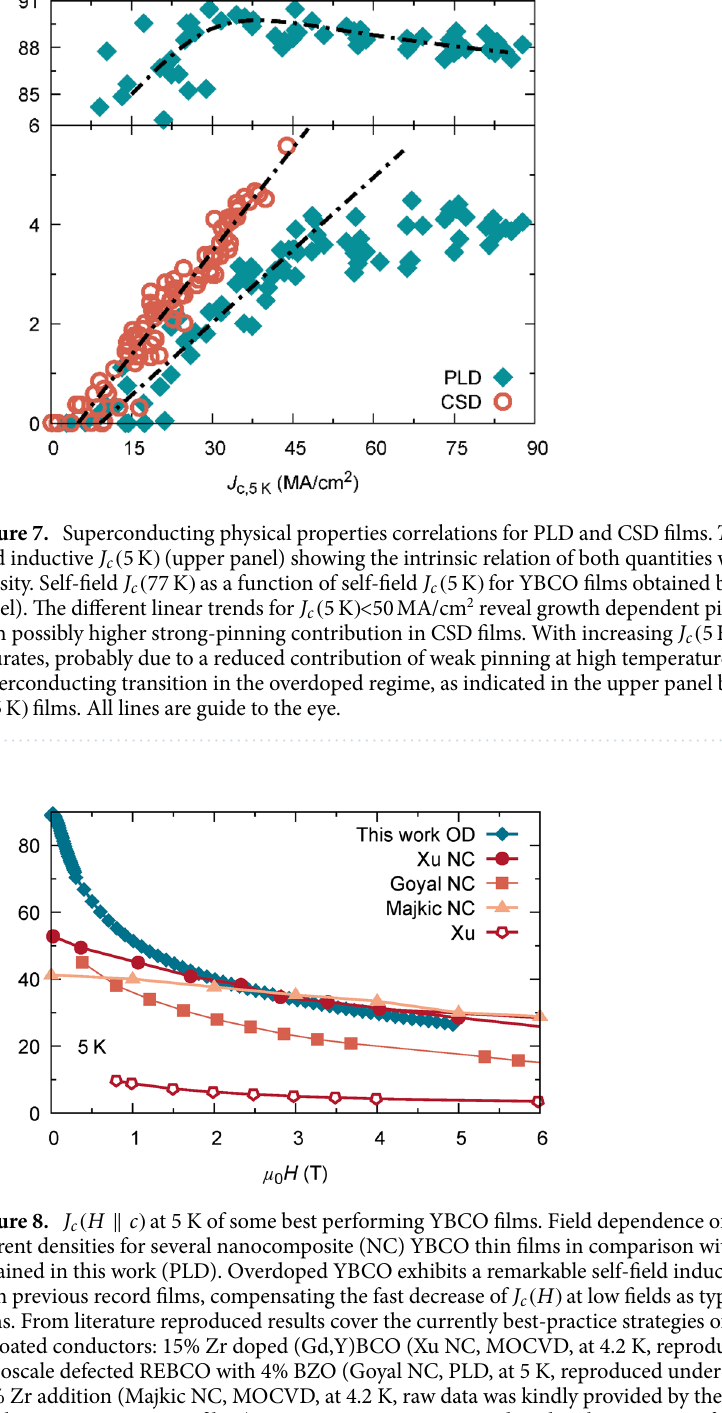
and n H (Eq. 4) from three independent experimental parameters. The distinct behaviour of J c observed at 5 K and 77 K, suggests that we have been able to modify the weak pinning individual strength through the modifi- cation of the condensation energy by doping. p -doping strategies with oxygen post-processing treatments are expected to be scalable and uniform in long length, therefore, we envisage a viable hybridisation of overdoping and nanoengineering of YBCO films, which offers powerful prospects to further push prevailing limitations of dissipation-free current transport in cuprate superconductors and Coated Conductors at high magnetic fields of interest for applications. We reinforce the interest to find ways to overdope YBCO films beyond the present